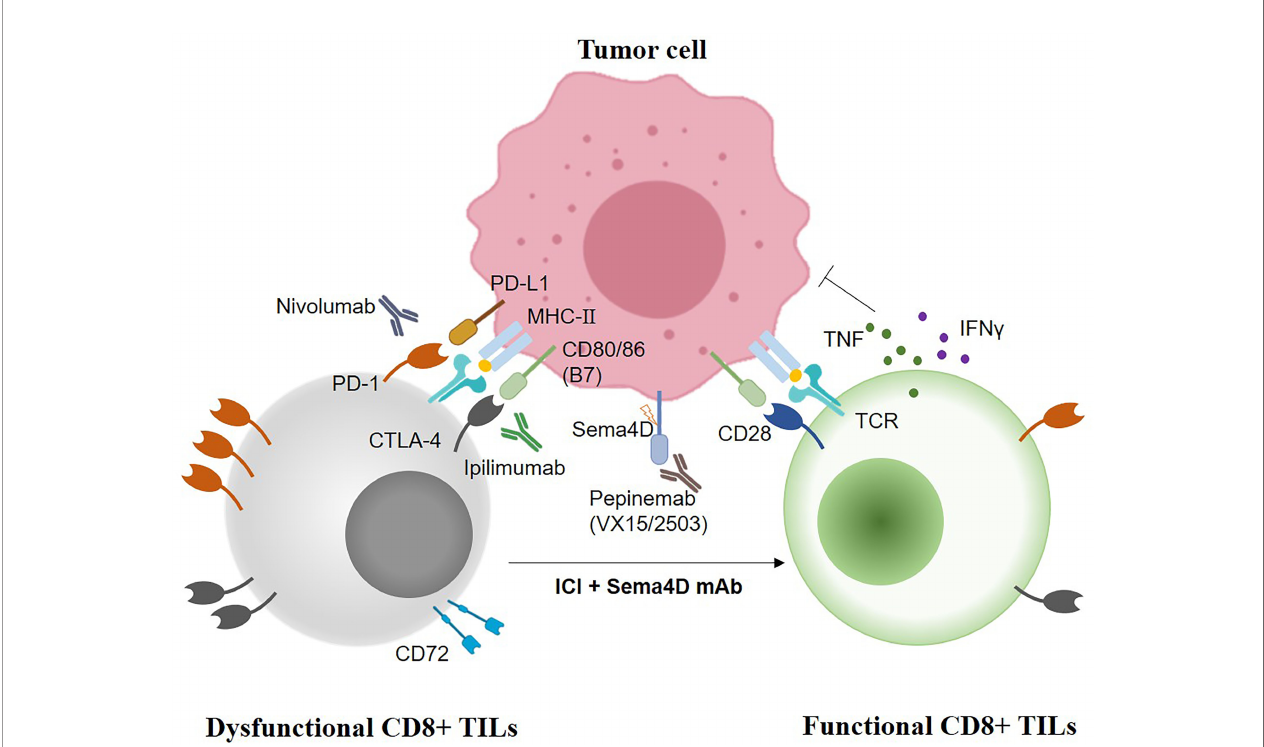
FIGURE 3 | The synergistic anti-tumoral strategies of combination Sema4D mAb with immune checkpoint inhibitors (Nivolumab, PD-1 inhibitor; Ipilimumab, CTLA-4 inhibitor, Pepinemab/VX15/2503, the humanized Sema4D